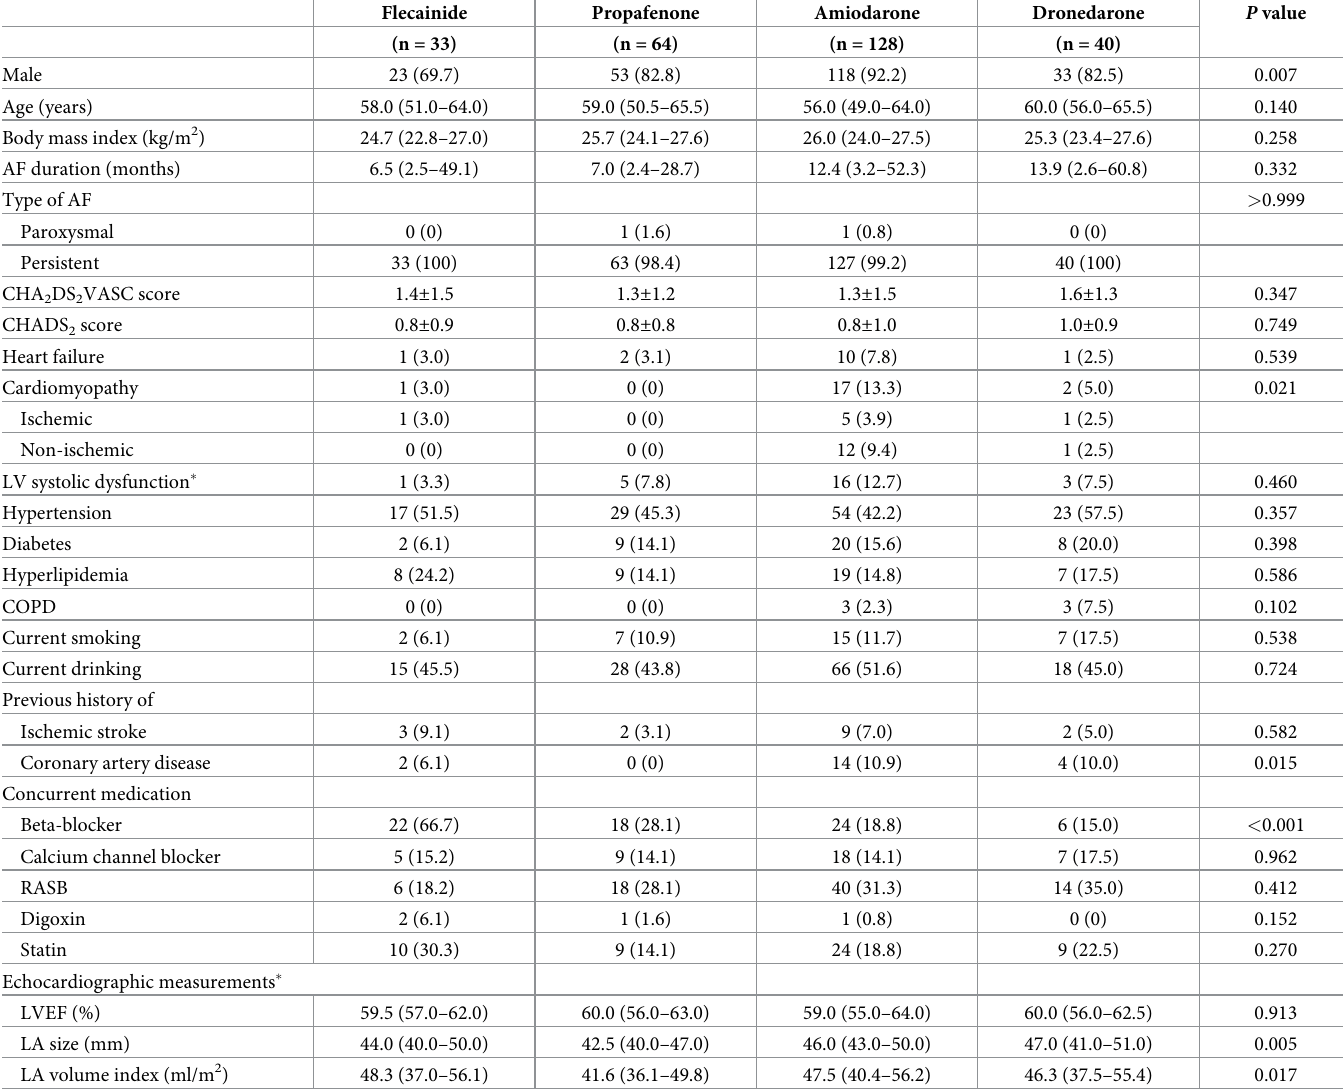
Table 1. Patient baseline clinical